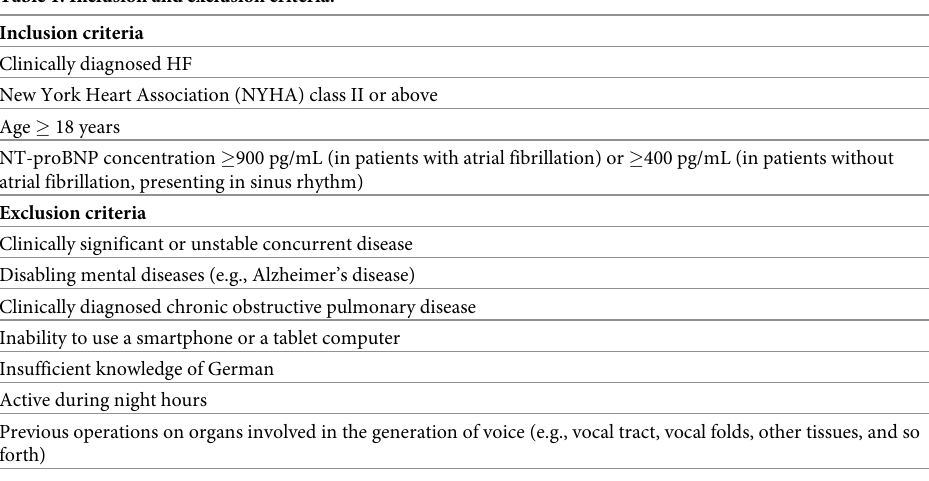
Table 1. Inclusion and exclusion